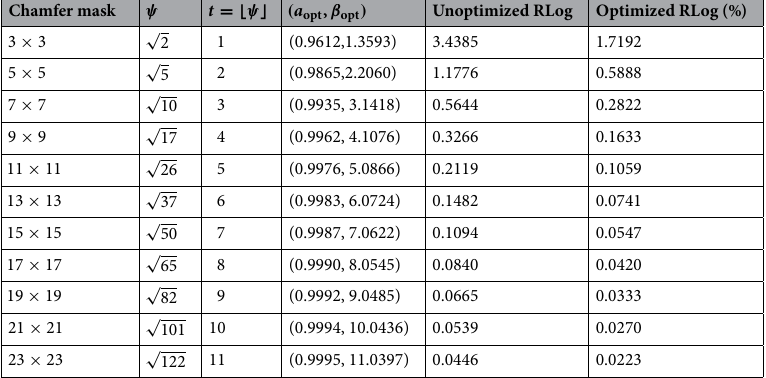
Table 1. Maximum RLog under unoptimized and optimized conditions of the Chamfer